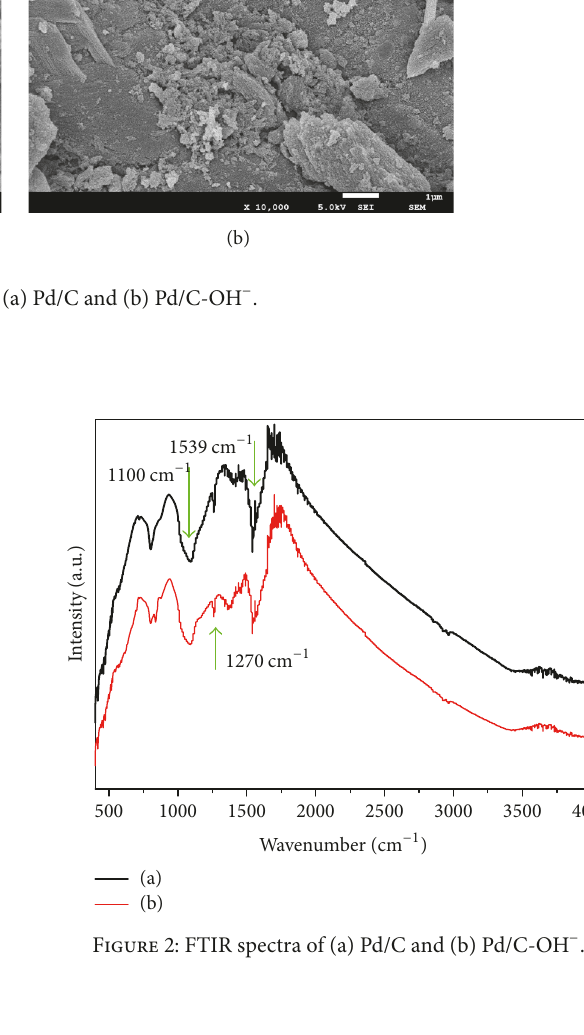
Figure 2: FTIR spectra of (a) Pd/C and (b) Pd/C-OH −